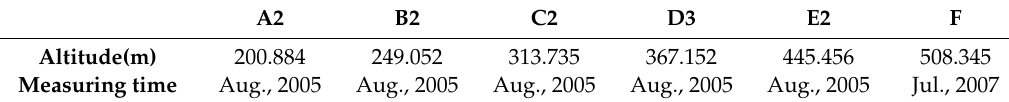
Table 1. Altitudes and measuring time of 6 stakes along the central flow line of AL. A2 B2 C2 D3